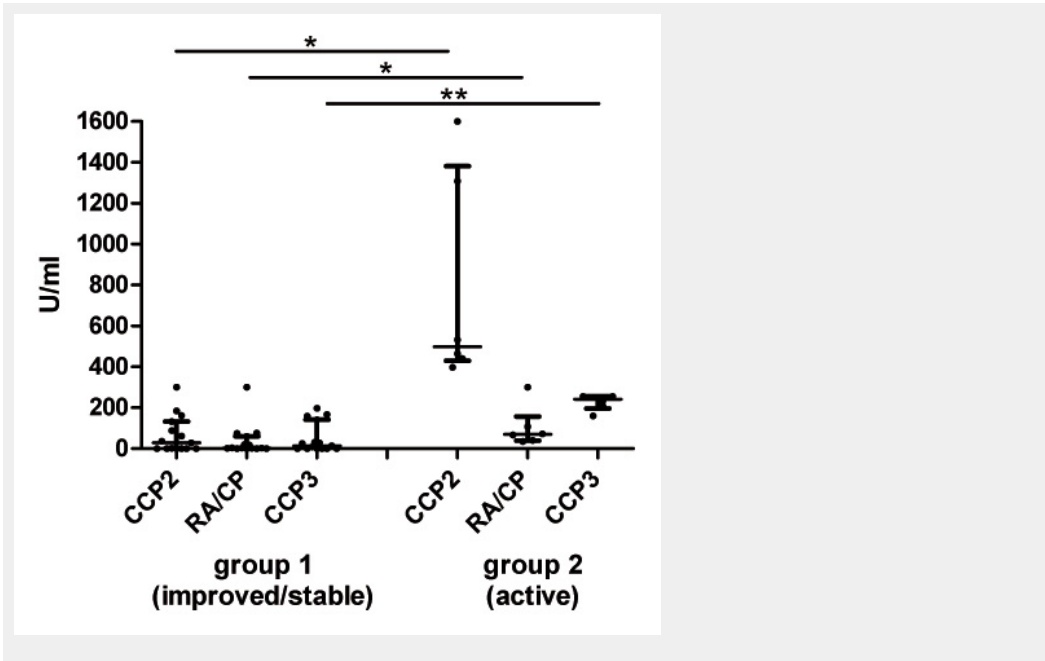
Figure 3 Lower ACPA levels in RA patients with inactive or ameliorated disease during pregnancy. ACPA levels measured by three different ACPA ELISA (CCP2 ELISA, RA/CP ELISA and CCP3 ELISA) at the third trimester in RA patients with low disease activity during pregnancy (group 1, n = 16) and in those with persistent active disease during pregnancy (group 2, n = 6). Lines show median and interquartile range; * P <0.05, ** P